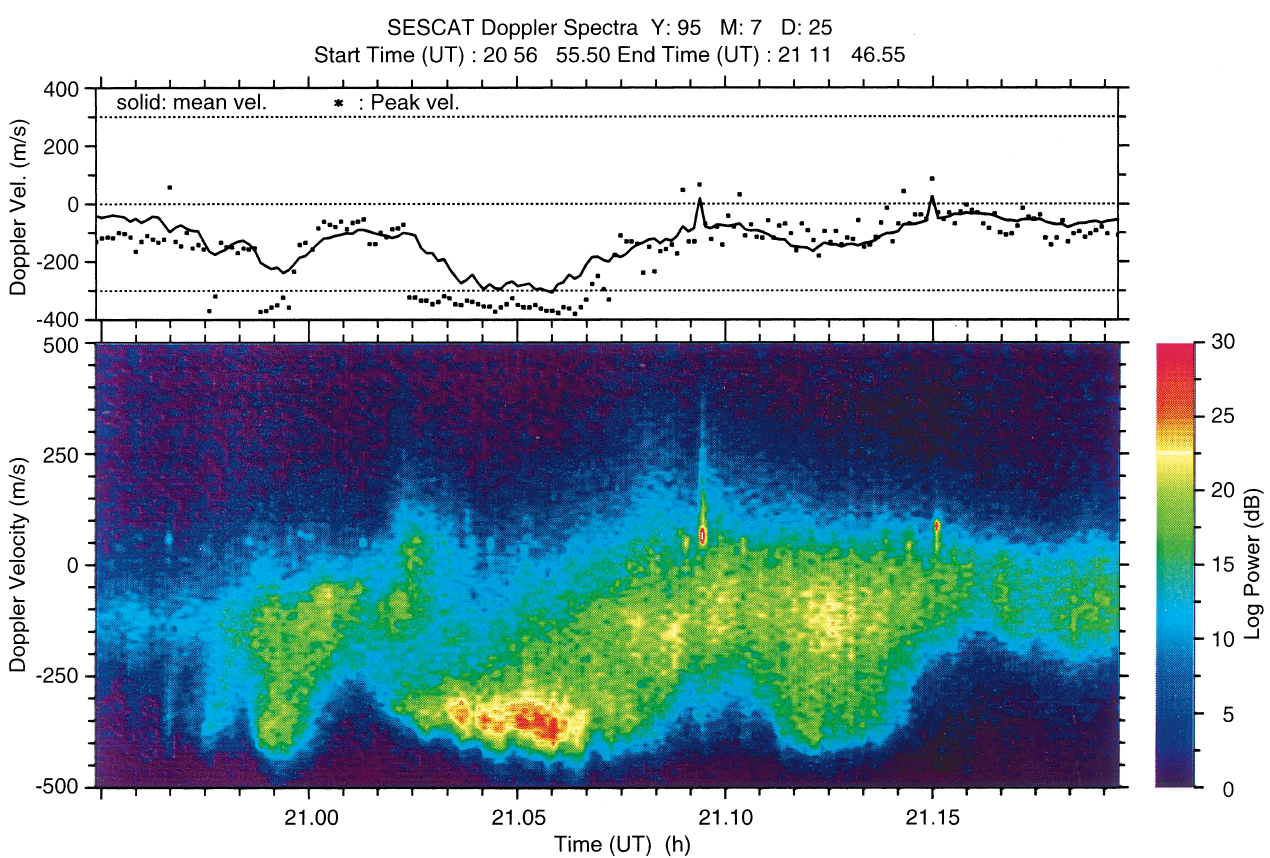
Fig. 4 . Another example showing three clear separate cases of type-1 echoes. As seen from the solid line in the top panel , these echoes occur